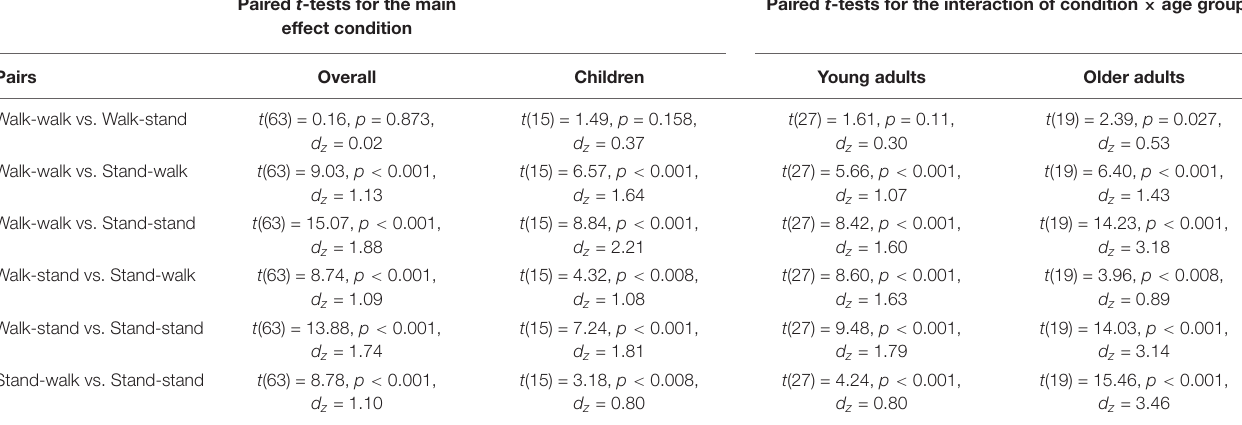
TABLE 2 | Follow-up analysis for main effect of condition and the interaction of condition and age